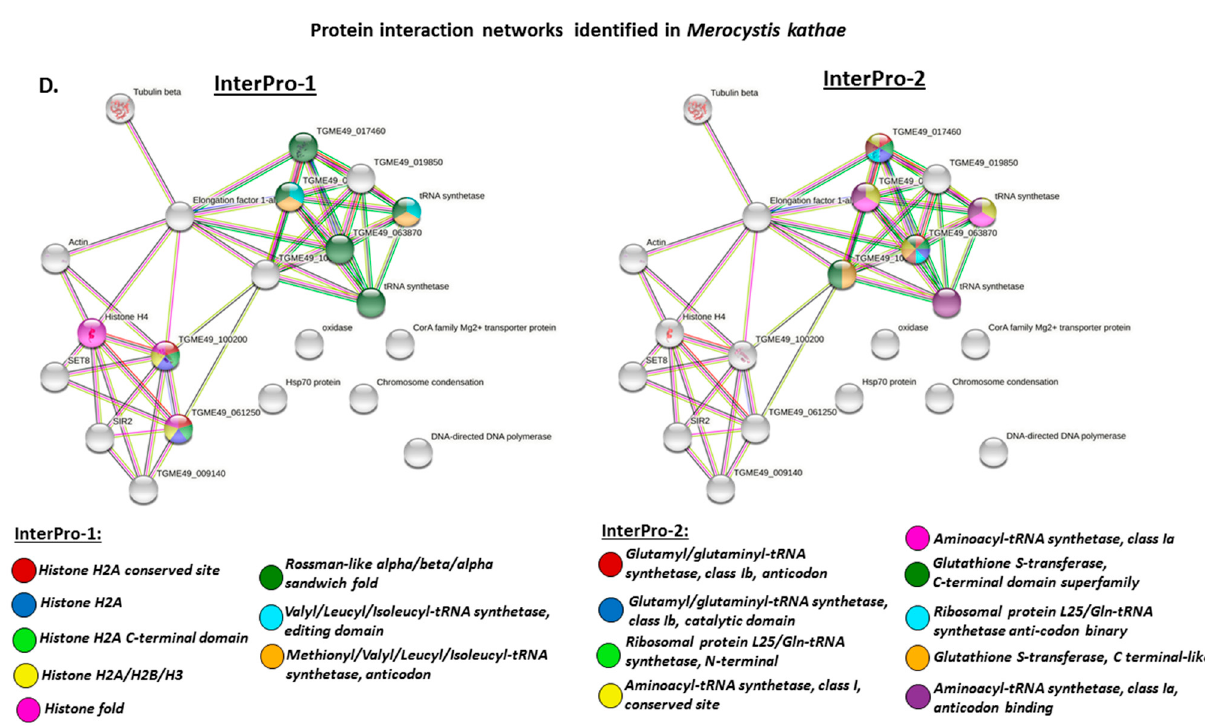
Figure 8. Local STRING network clusters and protein domains identified for deiminated proteins in Merocystis kathae . Protein–protein interaction network identified in M. kathae based on protein identifiers from T. gondii . PPI enrichment p -value: 0.000138. ( A ). Local network clusters and KEGG pathways are highlighted with the coloured nodes. ( B ). UniProt keywords are highlighted with the coloured nodes. ( C ). PFAM protein domains are highlighted with the coloured nodes. ( D ). Protein domains and features (Interpro-1 and -2) are highlighted with the coloured nodes. Colour coding for network nodes and interaction lines is included in the figure.